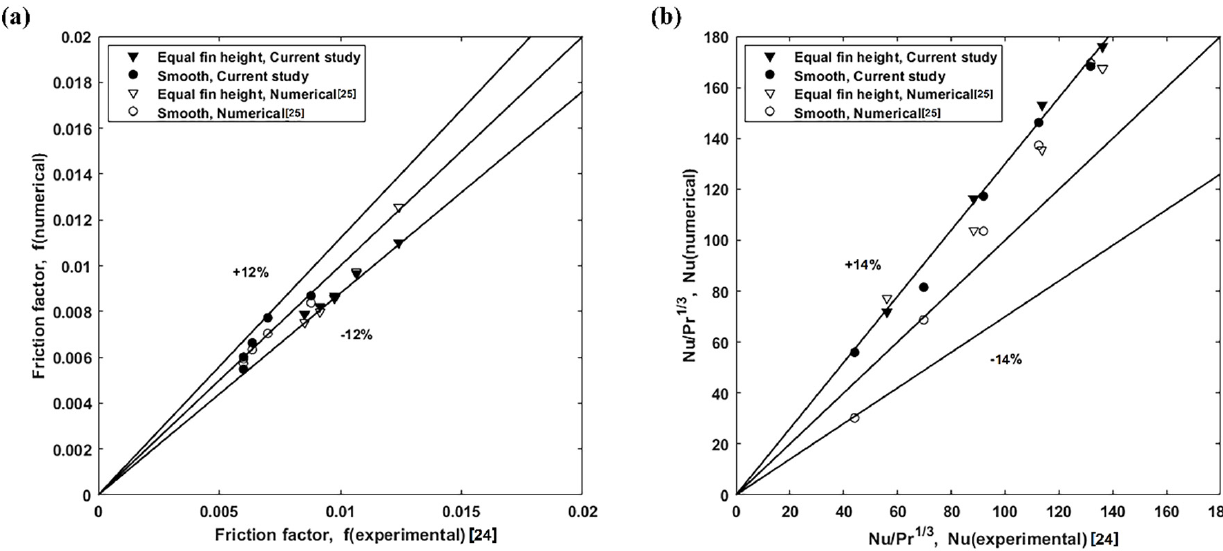
Figure 5. Validation of results with experimental and numerical data from literature, ( a ) friction factor; ( b ) Scaled Nu, Nu/Pr 1/3 .